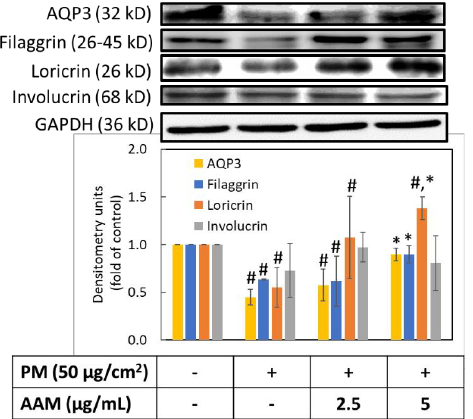
Figure 7. Effect of AAM on PM-induced skin barrier dysfunction in HaCaT cells. Data were from three independent experiments. Value are mean ± SD ( n = 3). # Significantly different from control group ( p < 0.05); * Significantly different from PM treatment alone ( p <